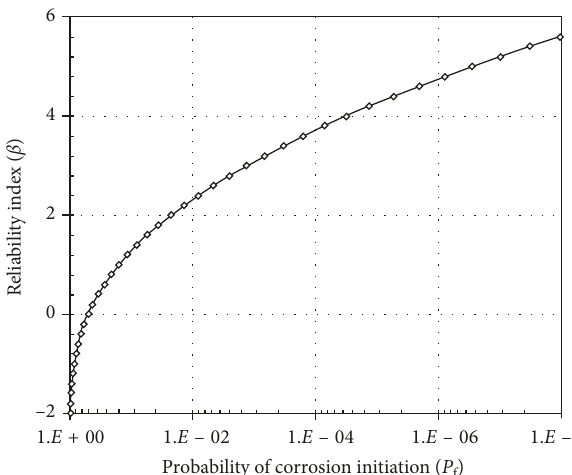
Figure 3: Relationship between reliability index and probability of corrosion initiation.